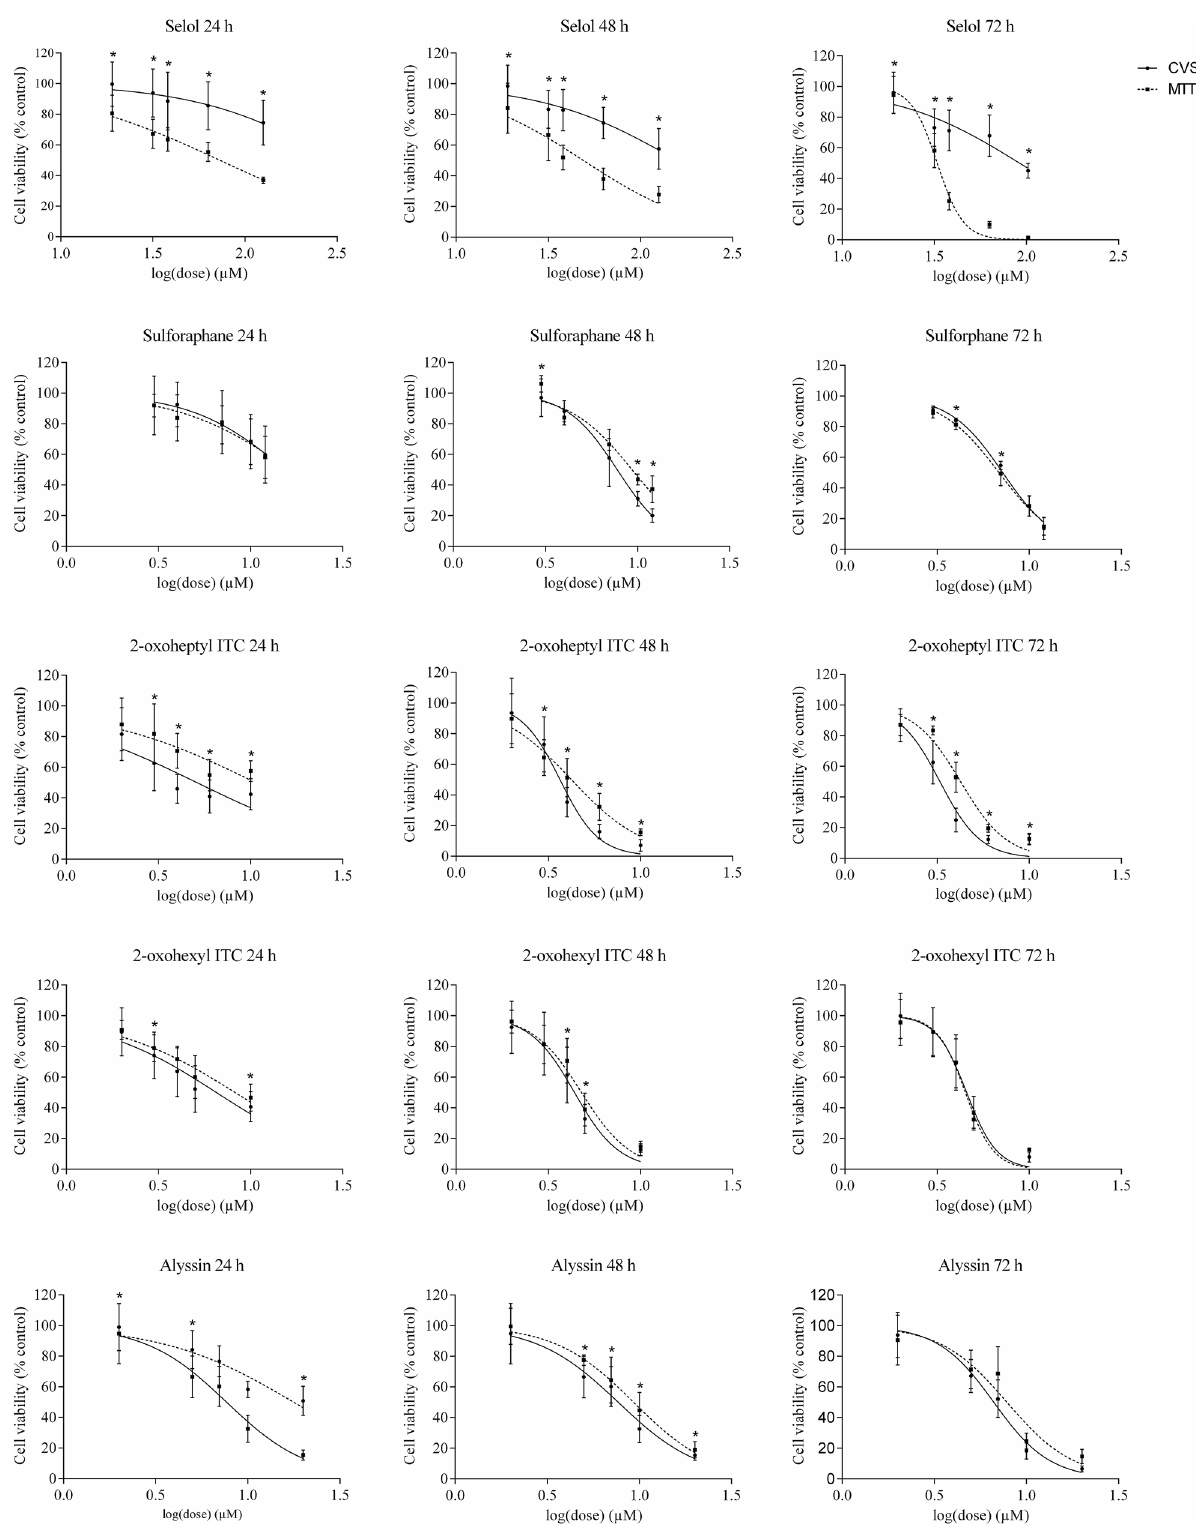
Fig 2. Effect of Selol, SFN, 2-oxoheptyl ITC, 2-oxohexyl ITC and alyssin on cell viability determined by MTT and CVS assays after 24, 48 and 72 h of incubation. Each bar represents the mean ± SD (n = 18). * Statistically significant difference between the growth inhibition effect determined by MTT and CVS assays, p <